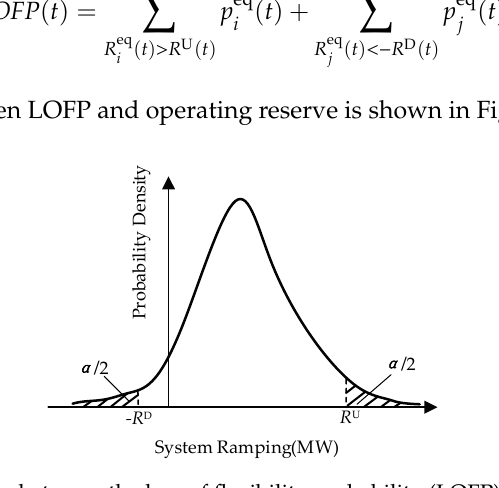
Figure 1. The relationship between the loss of flexibility probability (LOFP) and operating reserve.